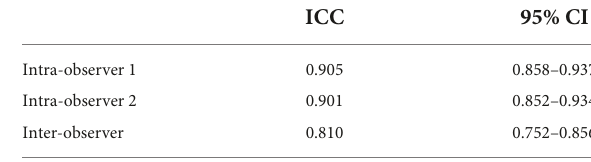
TABLE 1 Comparison of intra-observer and inter-observer consistency and